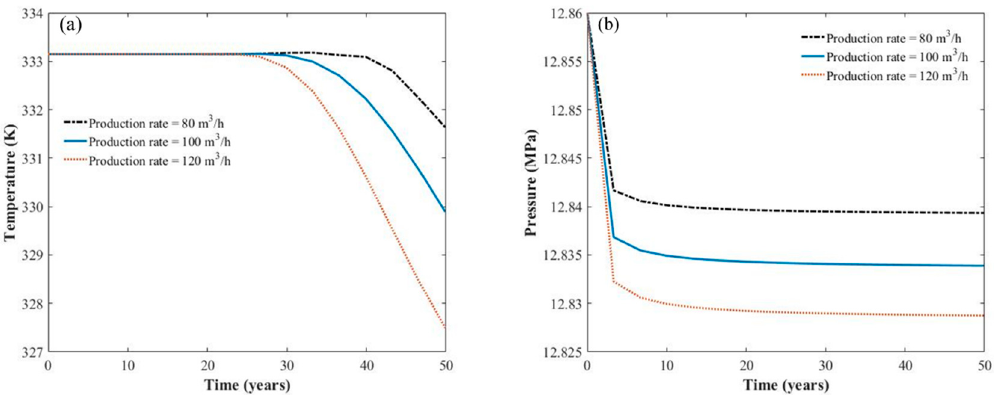
Figure 8. Time evolution of production well in production rate studies: ( a ) temperature at production well; ( b ) pressure at production well.